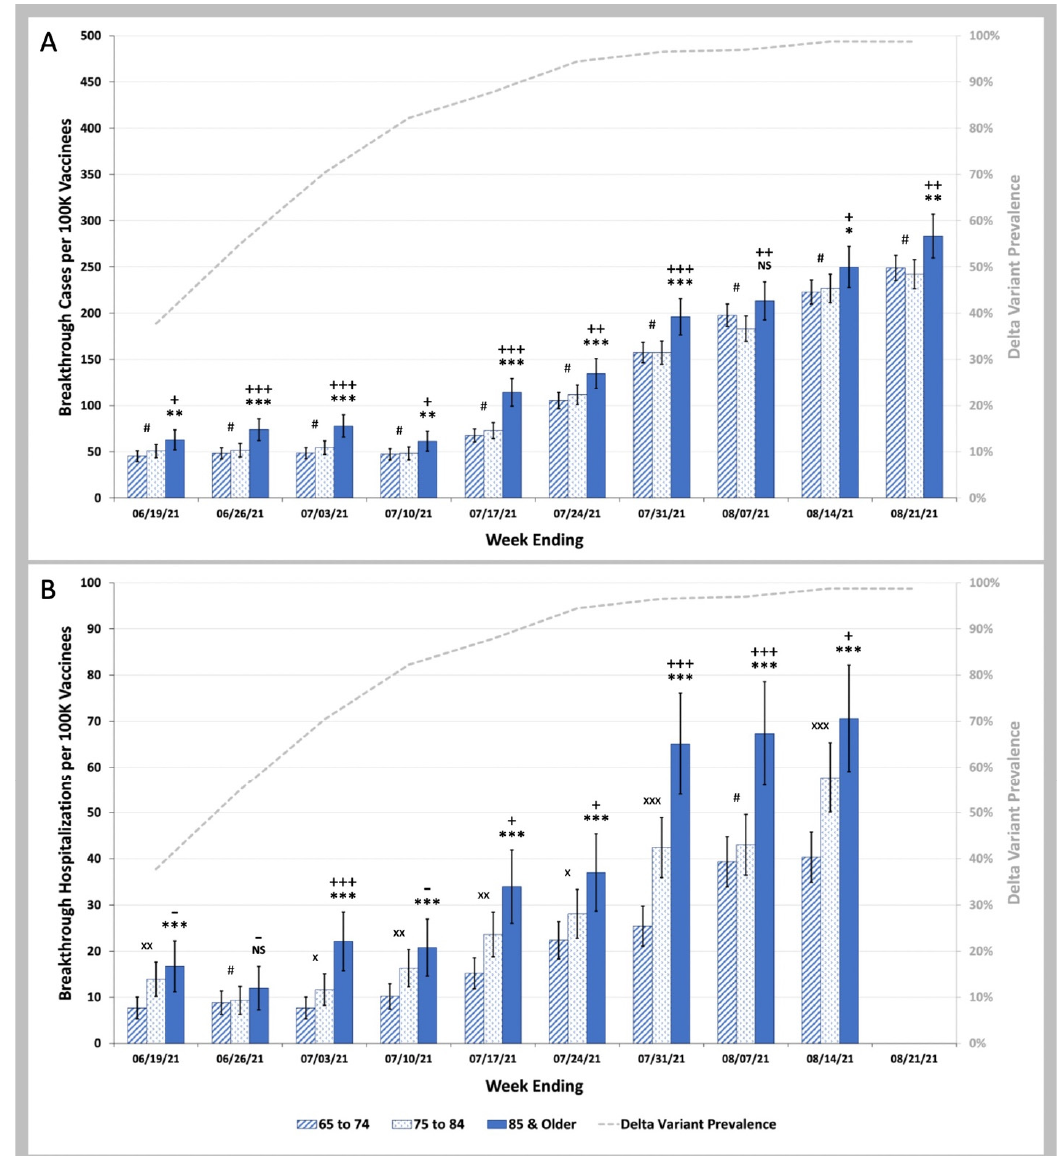
Figure 5. COVID-19 Breakthrough Infection and Hospitalization Rates in Individuals Vaccinated in the January Group, and in the March Group by Age. ( A )—Weekly infection rates per 100 K individuals vaccinated in the January 2021 and March 2021 vaccinee groups aged 65 to 74 (striped blue bars) vs. aged 75 to 84 (stippled blue bars) vs. aged 85 and older (solid blue bars). ( B )—Weekly hospitalization rates per 100 K individuals vaccinated in January 2021 and March 2021 aged 65 to 74 (striped blue bars) vs. aged 75 to 84 (stippled blue bars) vs. aged 85 and older (solid blue bars). Weekly SARS-CoV-2 Delta variant prevalence reported by the CDC (gray dashed line). Error bars indicate 95% CI. Symbols shown above the bars indicate p values for weekly rates for the vaccinees aged 75 to 84 being greater than weekly rates for the vaccinees aged 65 to 74, p values for weekly rates for the vaccinees aged 85 and over being greater than weekly rates for the vaccinees aged 65 to 74, and p values for weekly rates for the vaccinees aged 85 and over being greater than weekly rates for the vaccinees aged 75 to 84. # p ≥ 0.05; x p < 0.05; xx p < 0.01; xxx p < 0.001 by two-proportion Z-test (rate for 75 to 84 greater than rate for 65 to 74). NS p ≥ 0.05; * p < 0.05; ** p < 0.01; *** p < 0.001